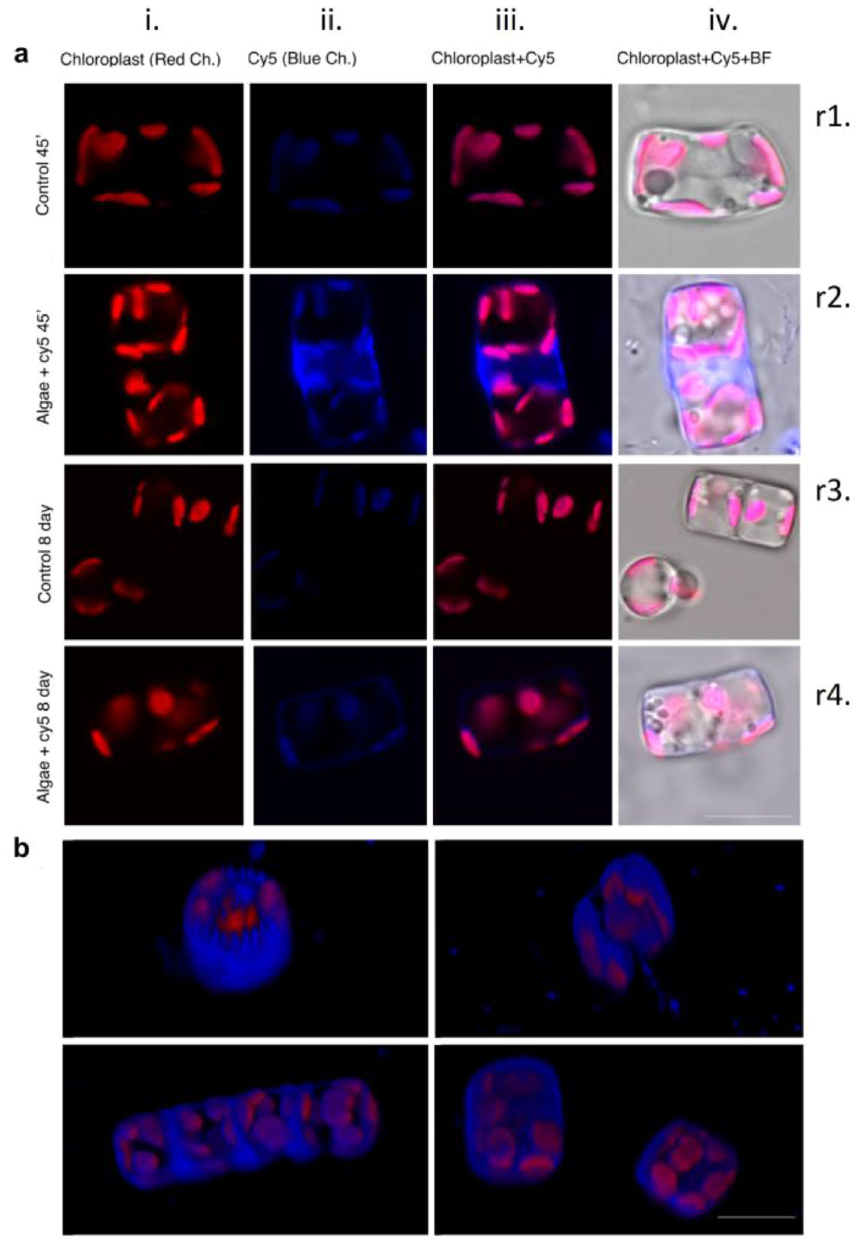
Figure 5. ( a ) Confocal microscopy image of diatom control (Ctrl), and diatoms grown with Cy5 1 μM after 45 min and 8 days’ incubation in normal lighting conditions (light: dark 16: 8 h). Red and blue colors were arbitrarily assigned for chloroplast and Cy5 emission, respectively. (Size bar 10 μm); ( b ) 3D reconstruction of diatoms incubated with Cy5 after 45 min (Size bar 10